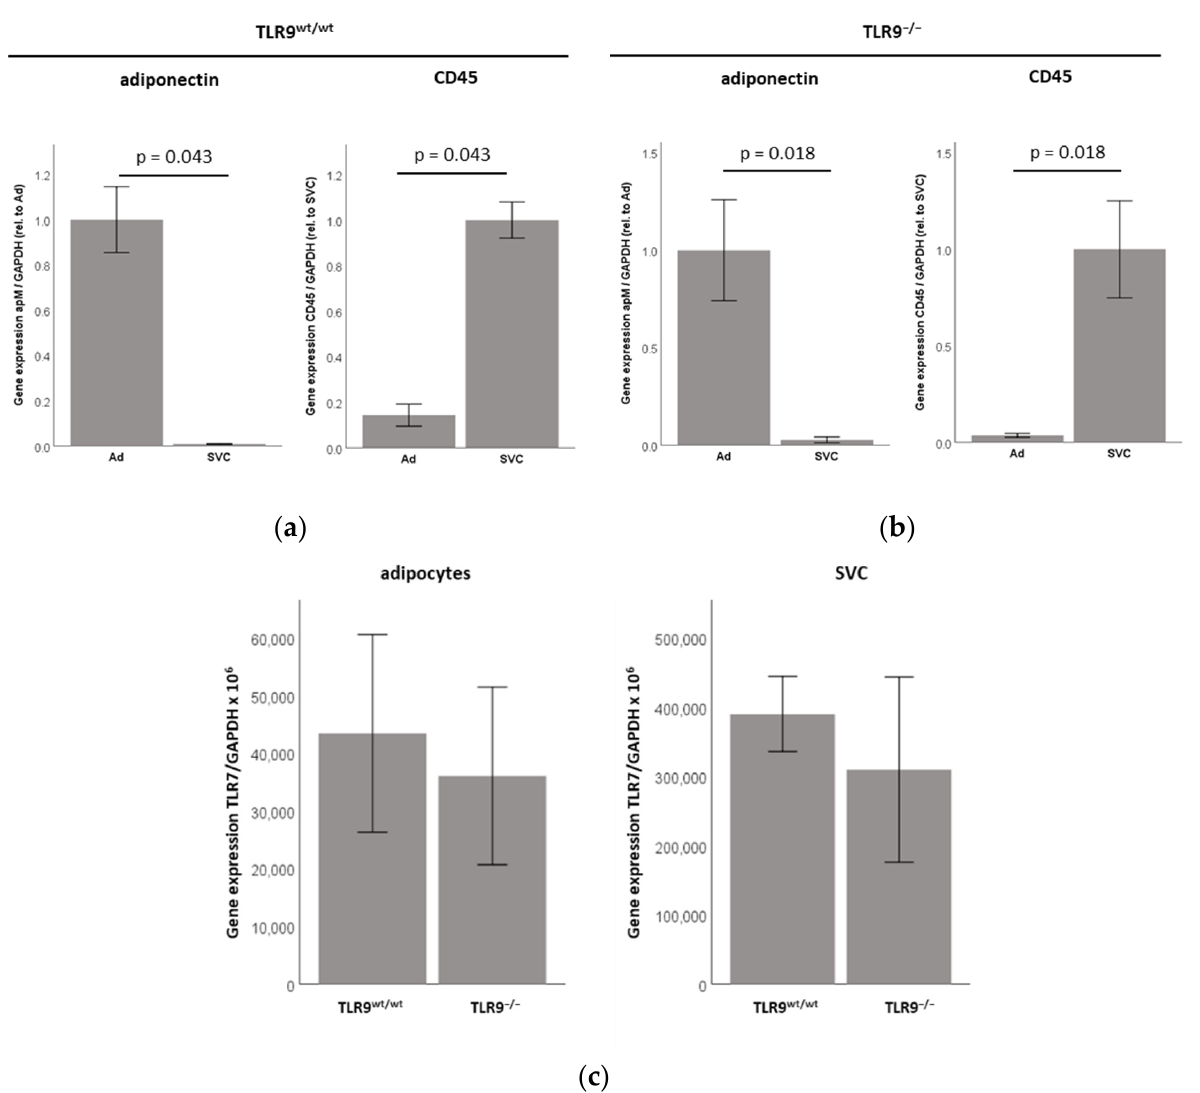
Figure 2. TLR7 mRNA is expressed in the stroma-vascular cell (SVC) and the adipocyte (Ad) fraction of intra-abdominal adipose tissue (AT) in TLR9 wt/wt and in TLR9 − / − mice. Adipocytes (Ad) and stroma-vascular cells (SVC) were isolated from intra-abdominal adipose tissue compartments of female TLR9 wt/wt and TLR9 − / − mice. ( a , b ) In preliminary experiments, the purity of adipocytes versus SVC after our isolation procedure was assessed by real-time PCR using adiponectin for the adipocyte fraction, and using CD45 (indicating leukocyte lineage) for the SVC fraction of cells in both genotypes: Adiponectin was almost exclusively expressed in the adipocyte fraction of cells, indicating that we reached a high purity of adipocytes during our isolation procedure. CD45, on the other hand, was almost exclusively expressed in the SVC fraction of cells, indicating that—as expected—this fraction contained a significant number of immune cells, which were absent in the adipocyte fraction of cells ( n = 5–7); ( c ) TLR7 mRNA expression (relative to GAPDH expression levels) was significantly stronger in the SVC fraction as compared to the adipocyte (Ad) fraction, however, no significant difference was found in TLR7 mRNA expression levels in adipocytes or in SVCs between TLR9 wt/wt versus TLR9 − / − mice ( n =